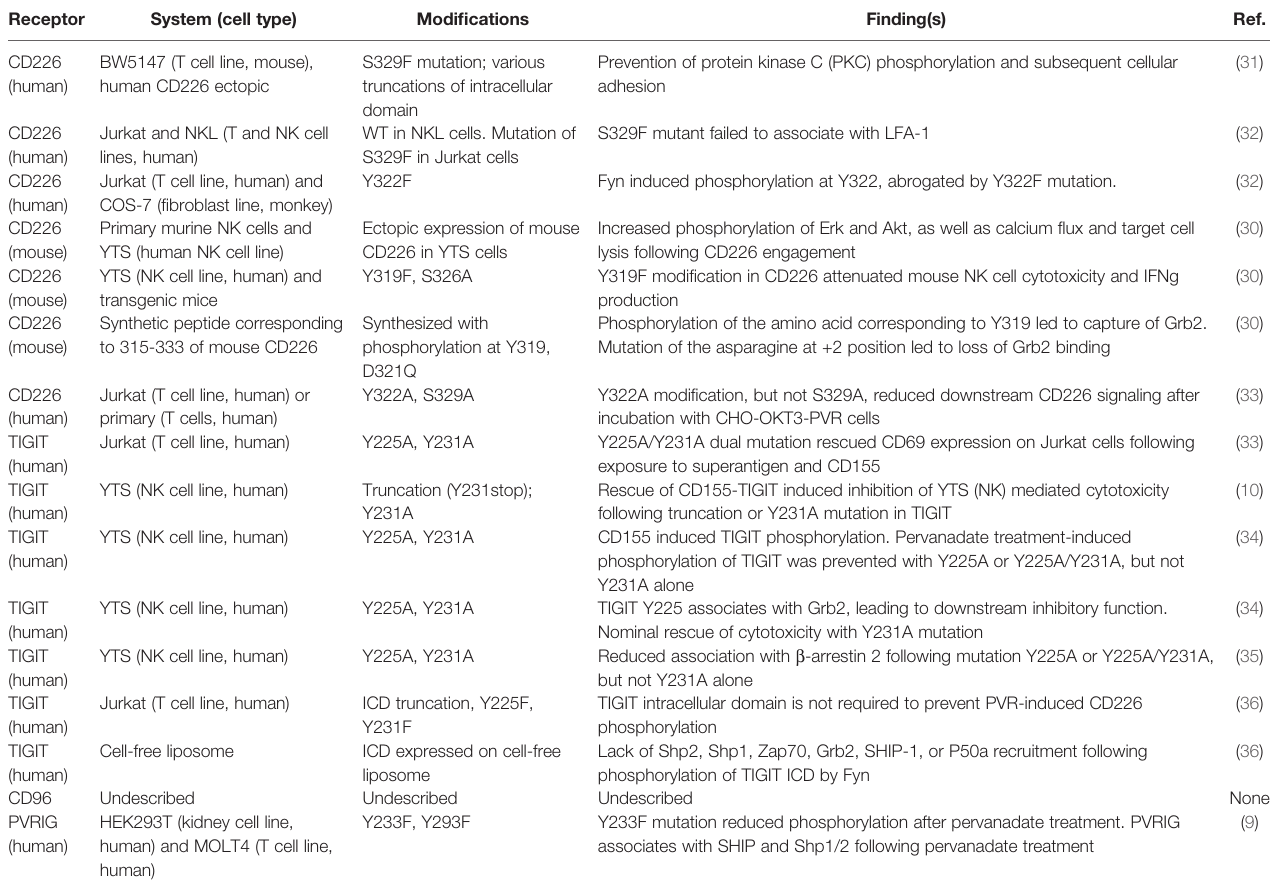
TABLE 2 | CD226 axis receptor ICD mutational studies and associated functional